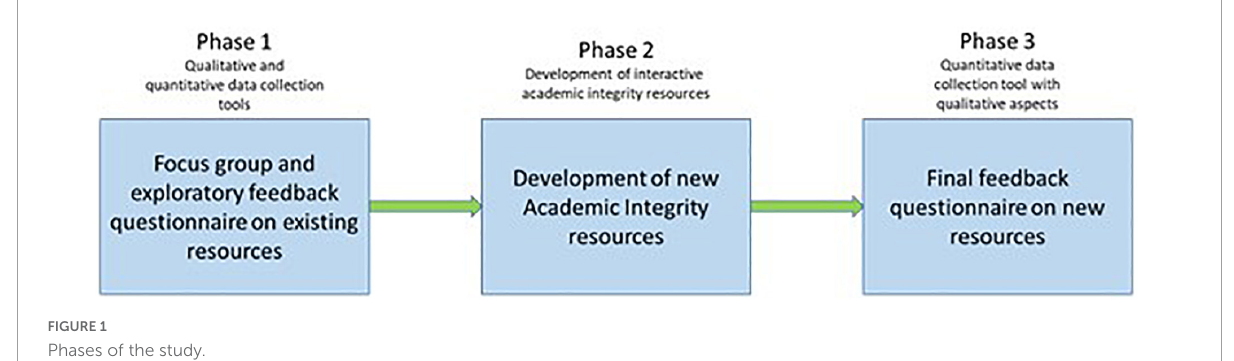
FIGURE1 Phases of the